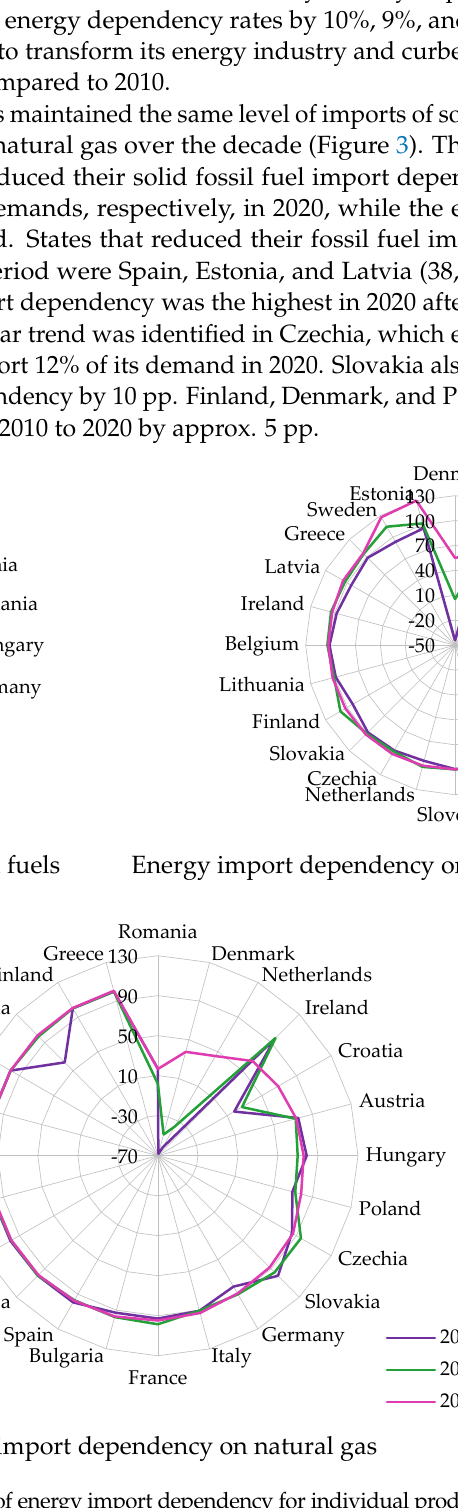
Figure 3. Values of energy import dependency for individual products in the years 2010, 2015, and